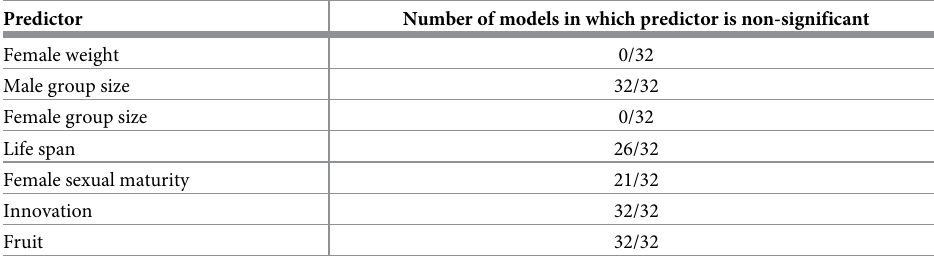
Table 4. Number of models in which each predictor were estimated non-significant ( p > 0.05) with Neocortex size as the dependent variable. N = 40.